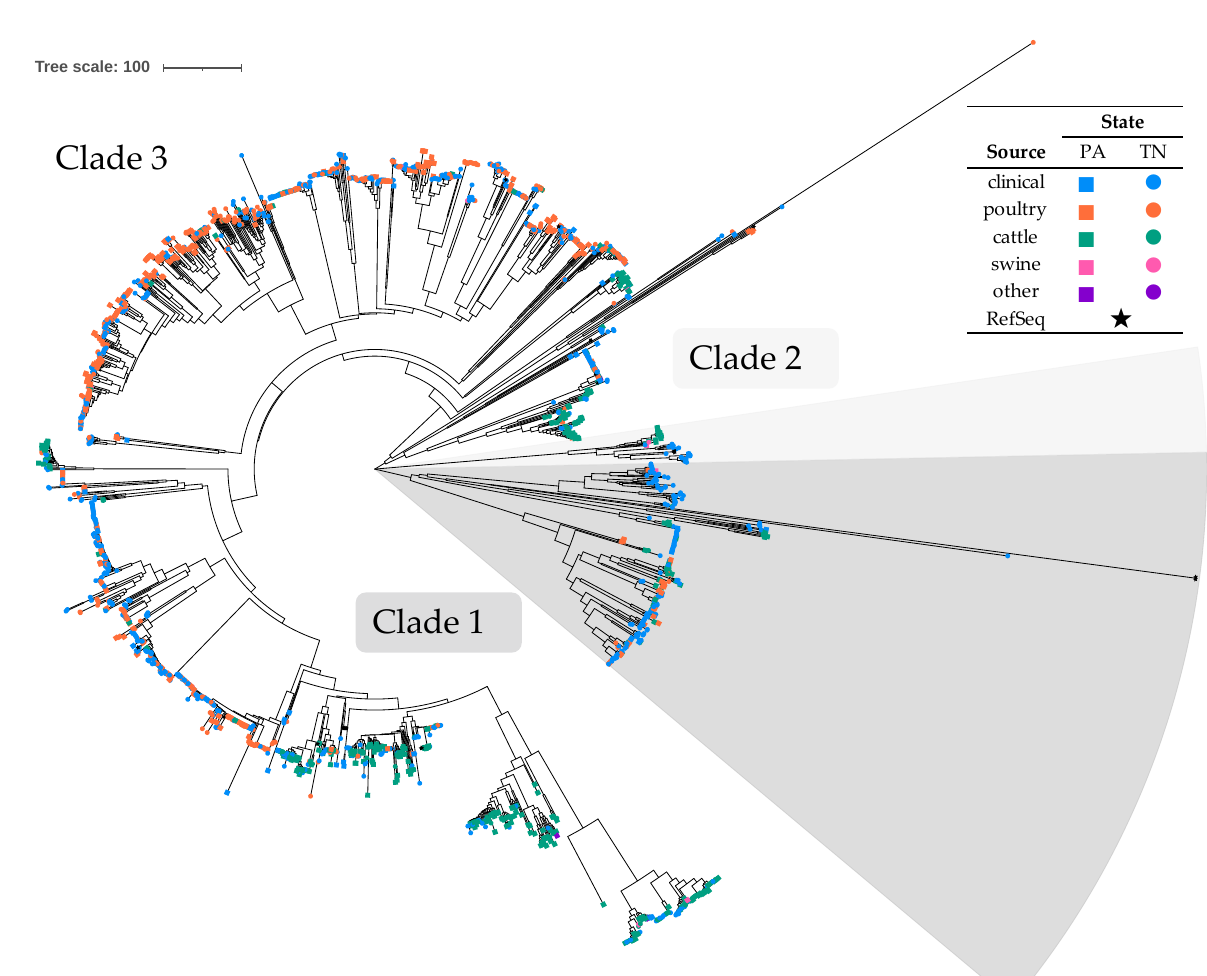
Figure 1. Neighbor-joining phylogenetic tree of C. jejuni isolates. The optimal tree with the sum of branch length equal to 37,842.9 is shown. The tree is drawn to scale, with branch lengths representing core SNP distances. There were a total of 6132 core SNP positions in the final dataset. Symbols at the end of tree leaves indicate isolation location and source (see legend). Figure S1 is an alternate rendering of the tree with bootstrap values and additional